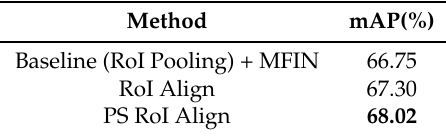
Table 4. Different RoI Pooling layer. The numbers in boldface indicate the best performance.